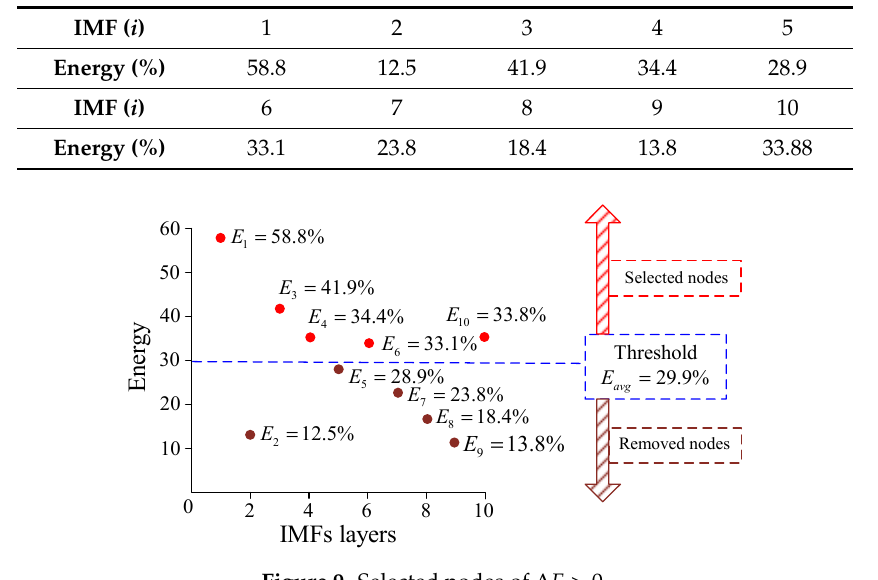
Figure 9. Selected nodes of ∆ E i > 0. Table 3. The distance between each of the